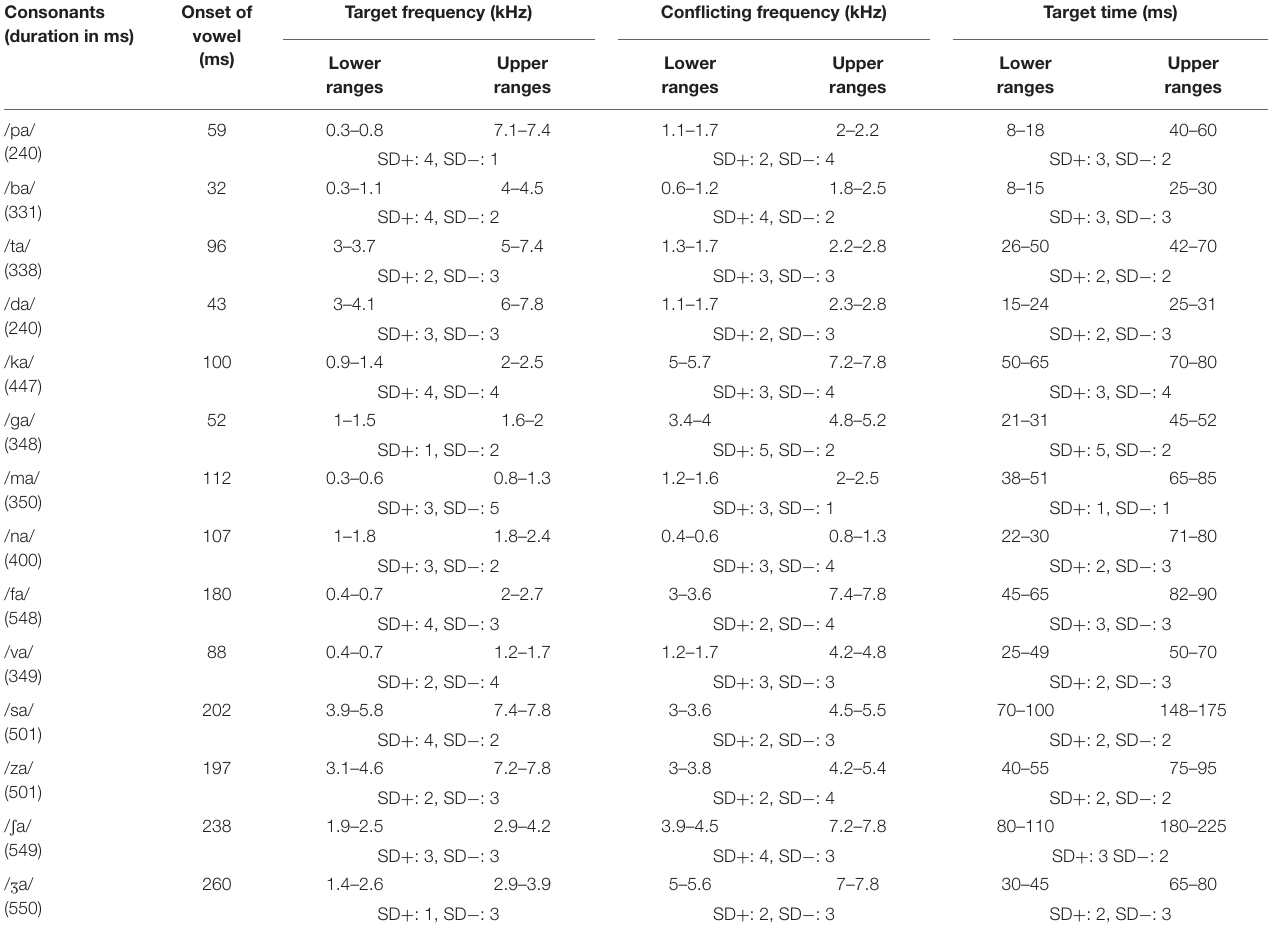
TABLE 1 | The lower and upper ranges of the target and conflicting frequency and time. Consonants (duration in ms)